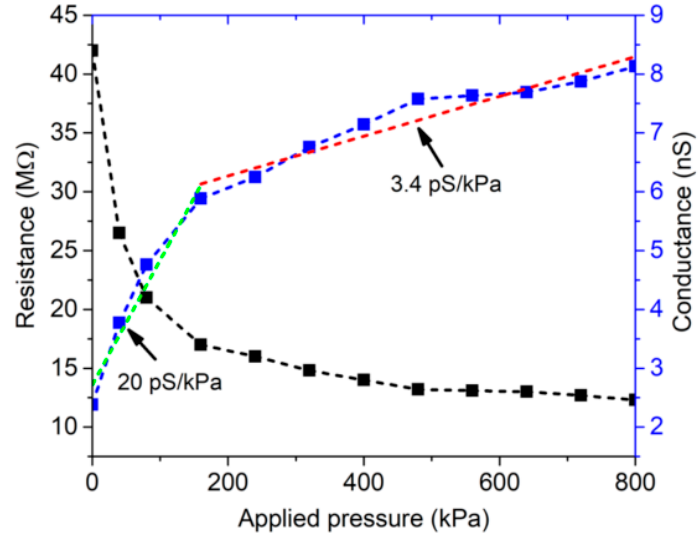
Figure 6. Measured resistance and conductance of the MO-07/RS 3D-printed grid as a function of applied pressure. Conductance = blue dot-line, Sensitivity about 20 pS/kPa and 3.4 pS/kPa = green and red line respectively; Resistance = black dot-line.